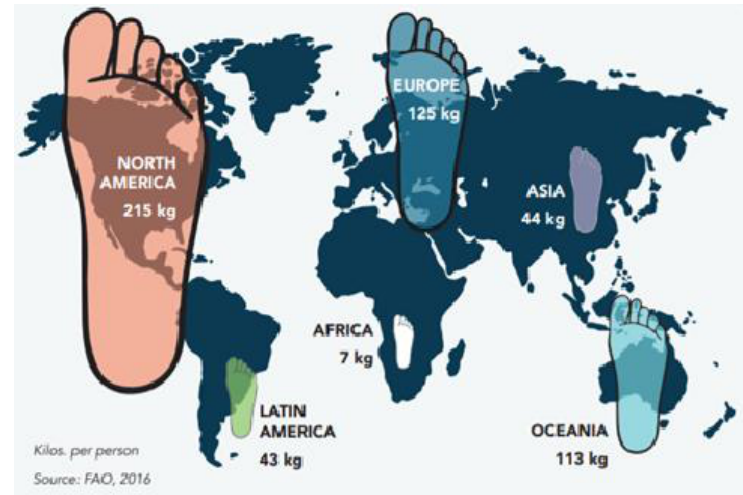
Figure A8. Per capita paper consumption, by region. Source: https://environmentalpaper.org/wp-content/uploads/2018/04/StateOfTheGlobalPaperIndustry2018_FullReport-Final-1.pdf (accessed on 8 June 2021).